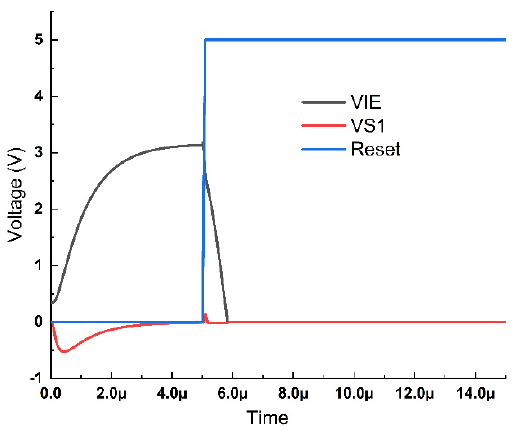
Figure 11. ( a ) Output current from four channels of discretized position circuit (DPC). ( b ) Output voltage of transimpedance amplifiers (TIAs).